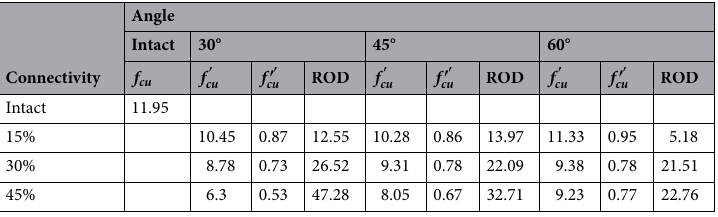
Table 5. Peak strength and reduction rate of specimens with different values fracture connectivity and ′′ ′ f cu is the peak strength of intact soft rock; f ′ f angle(the unit for f cu f cu are MPa). cu ′′ fractured soft rock; f cu is the normalized peak strength of the fractured soft rock; and ROD is the reduction rate of the peak strength.